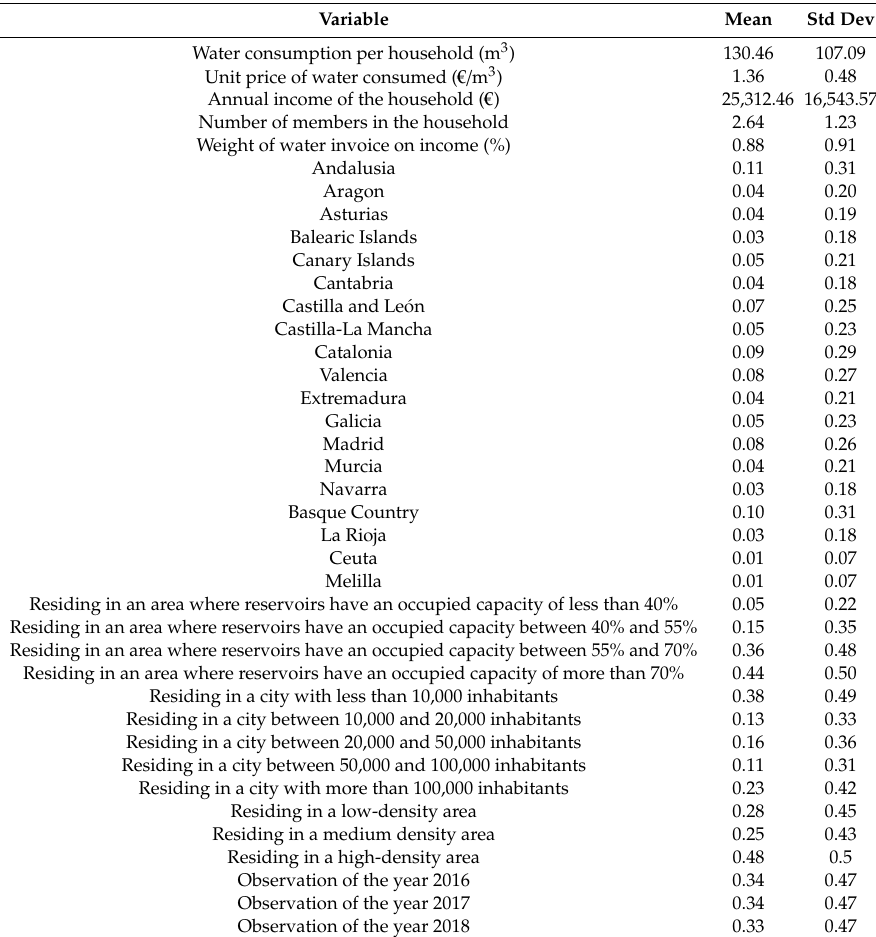
Table A2. Descriptive statistics of exploratory